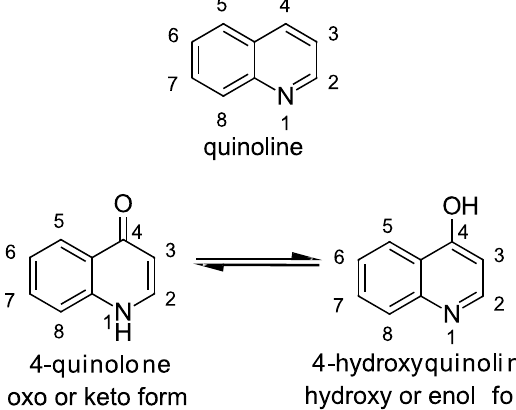
Figure 1. Chemical structures of quinoline and 4-quinolone scaffolds.